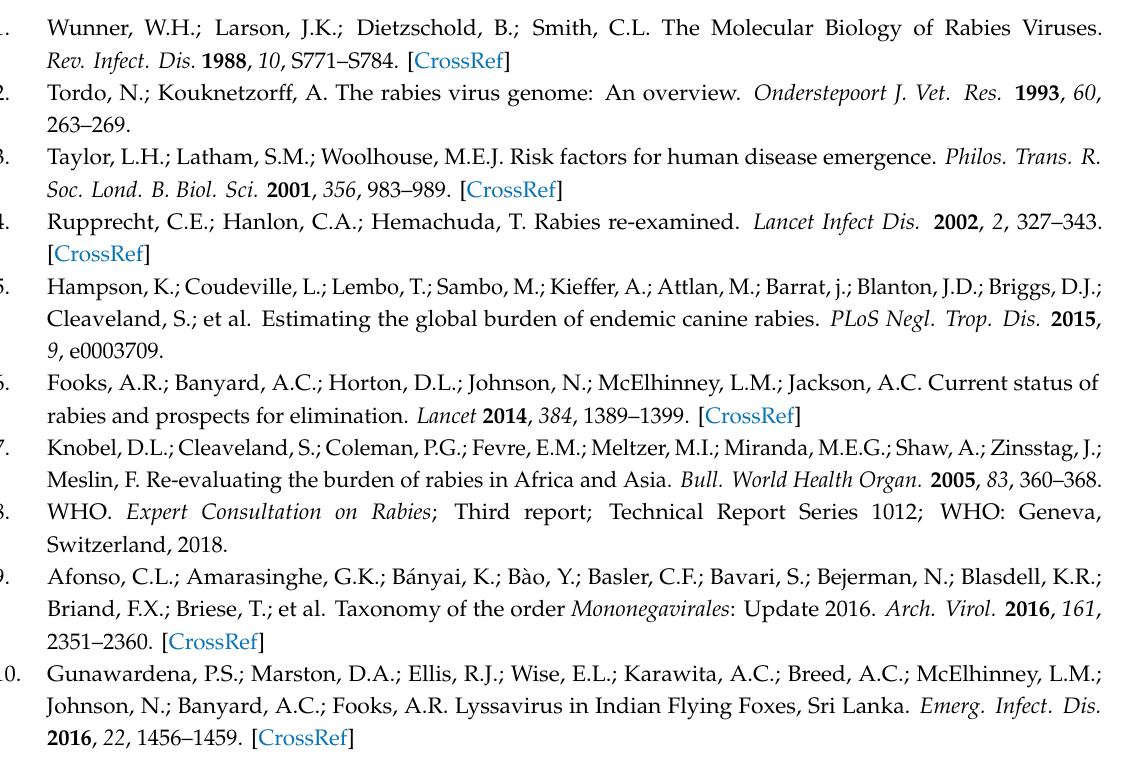
Table S1: PCR primers used in the study, Table S2: RABV sequences used for phylogenetic analysis with African civet sequences (Figure